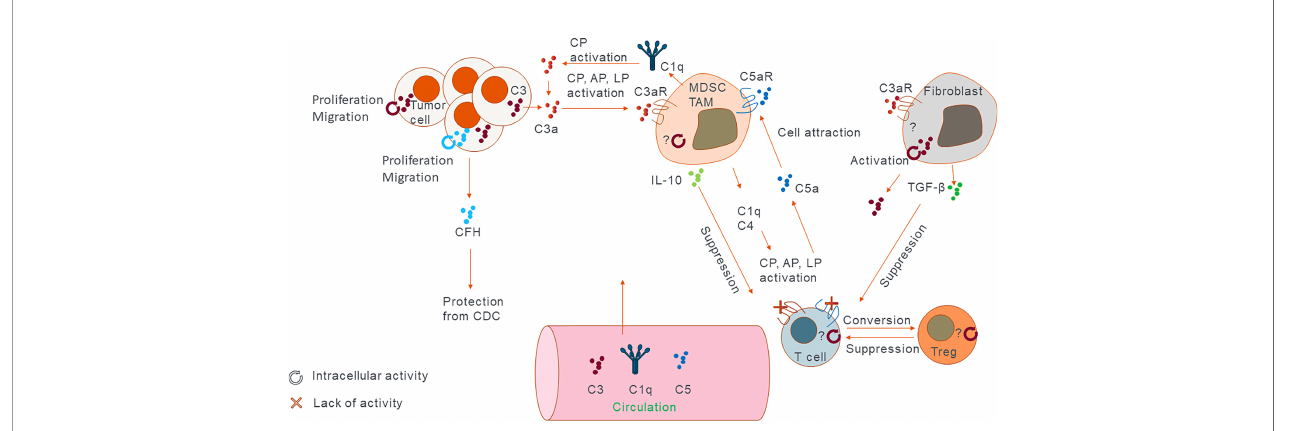
FIGURE 1 | Sites of complement expression and activation. Cartoon representing the main sources of complement in the tumor and their main modes of activation and action. C3 and factor H have shown to exert their function both intra- and extracellularly. Other proteins such as C5 were shown to have extracellular function via its receptors. Generally extracellular complement works by inducing immunosuppressive phenotype. Intracellular complement has the potential to modulate immune cell function in similar fashion or by directly increasing proliferation and migration capacity of the cancer cells themselves. In addition, lack of C3aR and C5aR signalling on T cells can convert them into Tregs which in turn can suppress other T cells ’